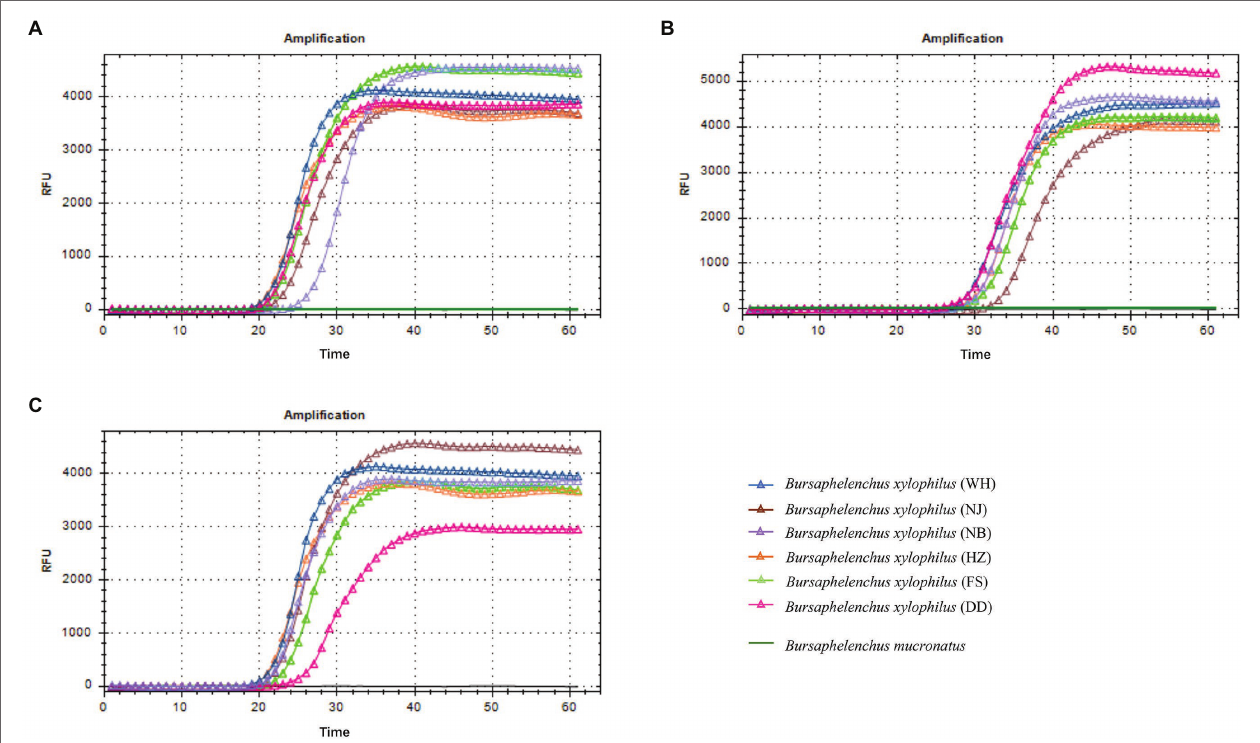
FIGURE 2 | Specificity of the LAMP primers for Bursaphelenchus xylophilus . (A) Bx-tlp-1 gene; (B) Bx-tlp-2 gene; (C) Bx-cpi gene; WH: LAMP results for B. xylophilus from Shandong; NJ: LAMP results for B. xylophilus from Jiangsu; NB: LAMP results for B. xylophilus from Zhejiang; HZ: LAMP results for B. xylophilus from Guangdong; and FS and DD: LAMP results for B. xylophilus from